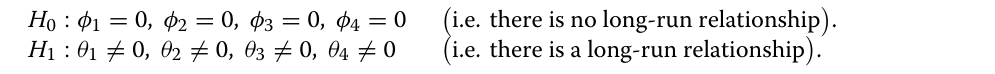
** and *** represent the non-rejection of the alternative hypothesis at 5% and 1% levels correspondingly